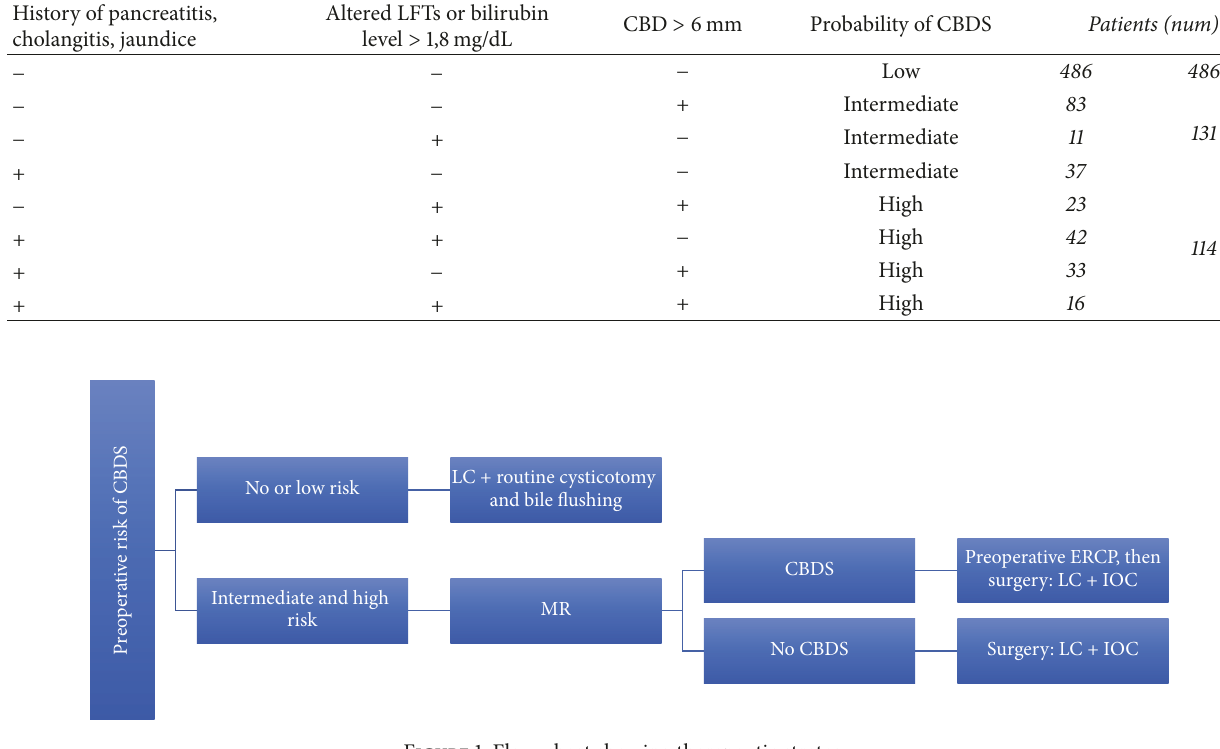
Figure 1: Flow-chart showing therapeutic